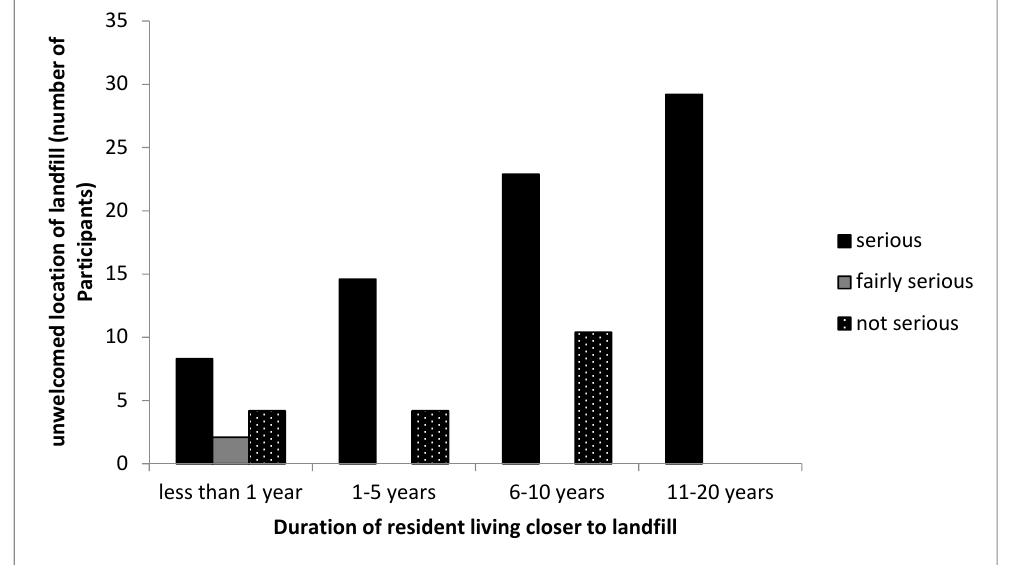
Figure 4. Cross-tabulation between the duration participants lived in the CL community and the seriousness of the unwelcomed location of the landfill. Note that the no bar section in the figure indicates there was no response by the participant.